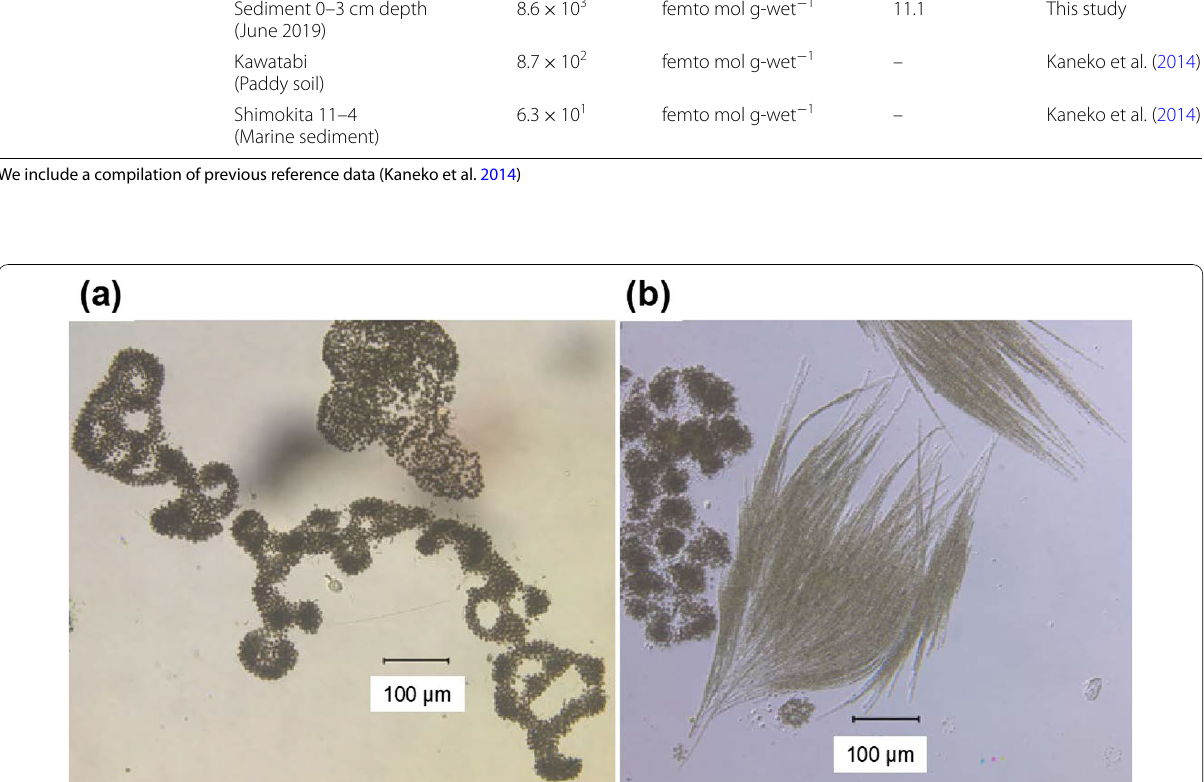
Fig. 5 Photomicrograph of the planktonic cyanobacterial sample collected in June 2019. The cyanobacteria in Lake Suwa mainly include Microcystis ( a ) in addition to other cyanobacteria, such as Aphanizomenon ( b ). We note previous studies regarding the average cellular dry weight and average cellular volume of Microcystis aeruginosa (2.0 10 − 11 g cell − 1 , Li et al. 2014; 65 µm 3 cell − 1 , Olenina et al. ×